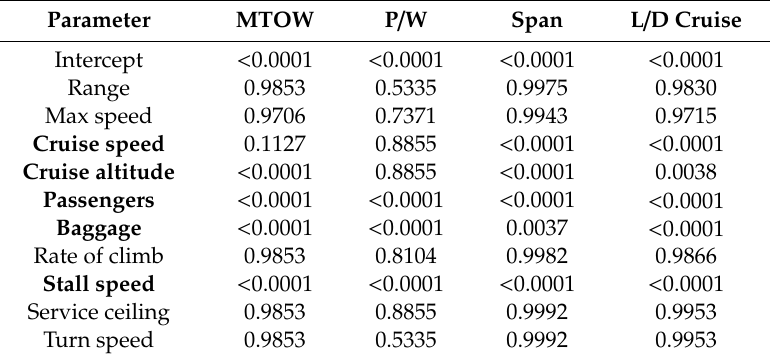
Table 15. Independent design parameter p